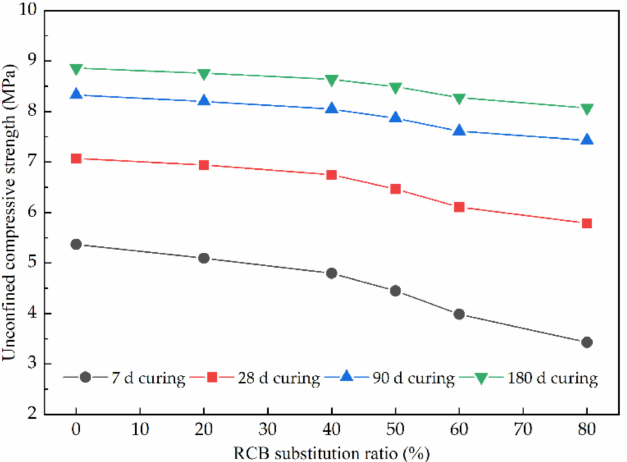
Figure 5. The unconfined compressive strength of CSM with different RCB substitution